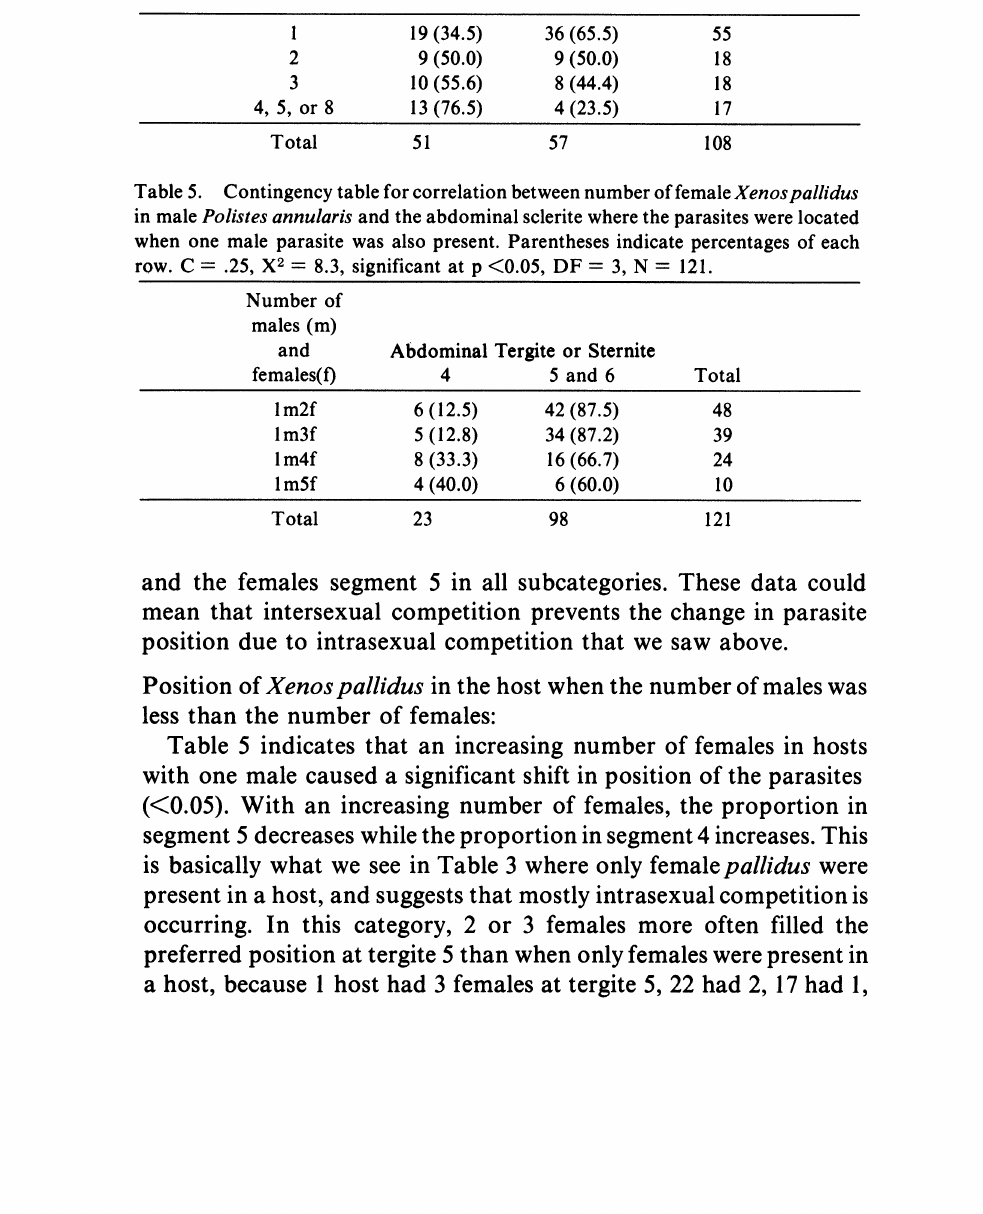
Table 4. Contingency table for correlation between number of male Xenospallidus in male Polistes annularis and the abdominal sclerite where the parasites were located. Parentheses indicate percentages of each row. C .29, X 10.1, significant at p <0.02, DF